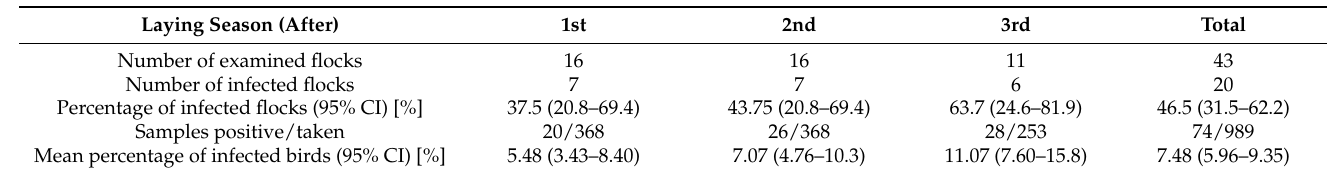
Table 1. The prevalence of Blastocystis infection in reproductive geese flock. Twenty-three samples from each flock were taken.